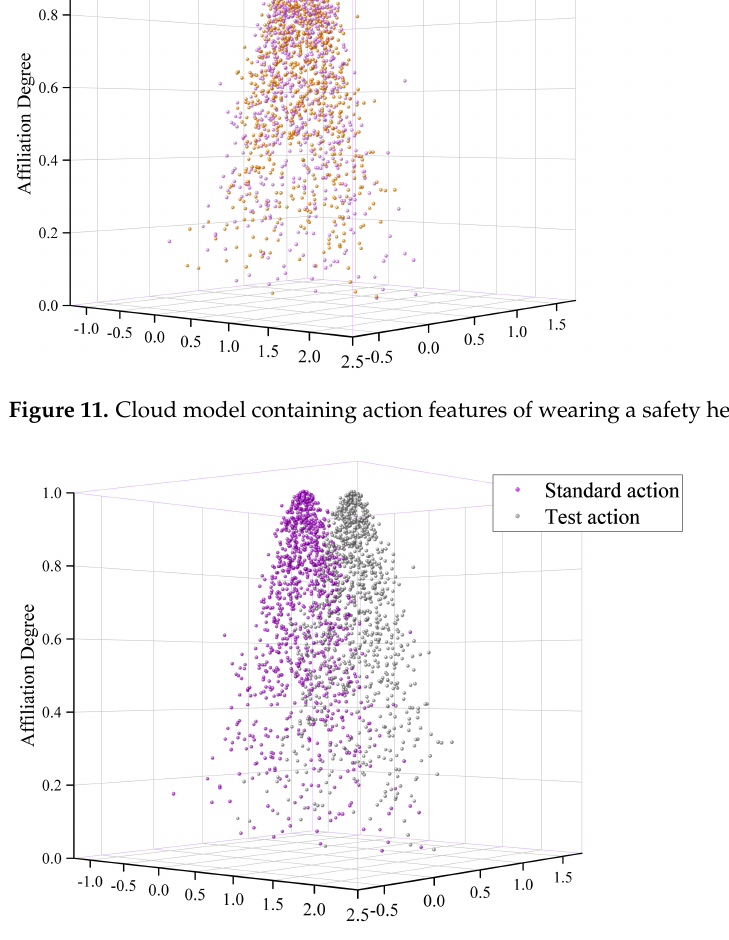
Figure 12. Multidimensional adaptive entropy cloud model comparison diagram of the test action and standard